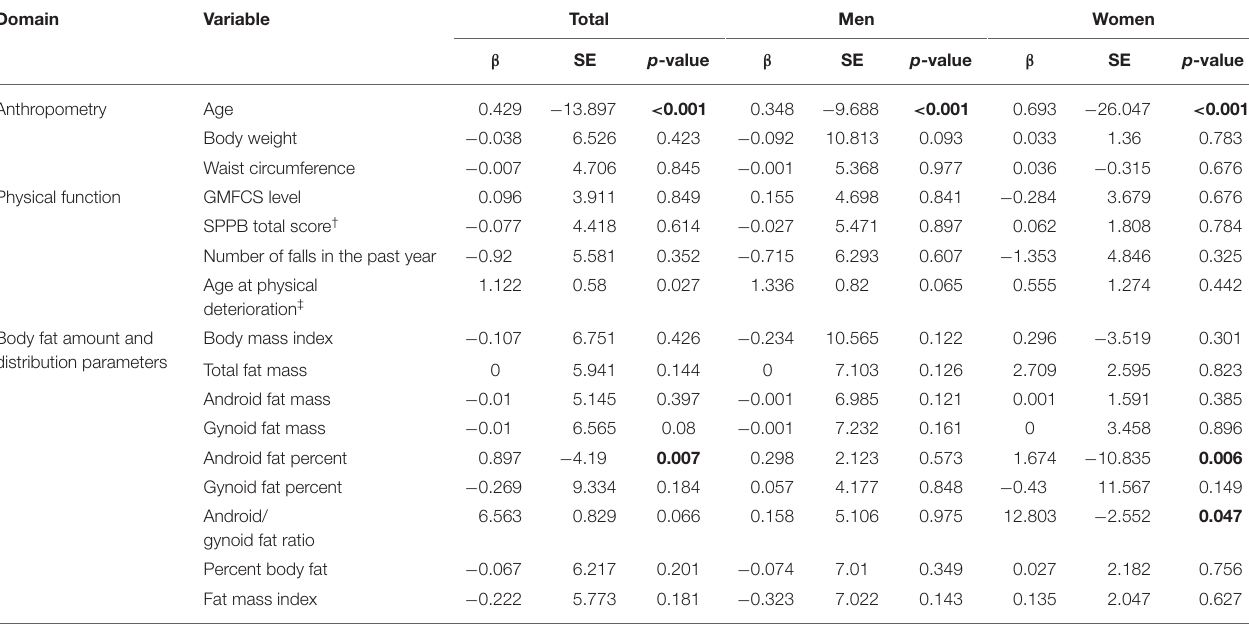
TABLE 3 | Univariable regression analyses for the Framingham risk score.